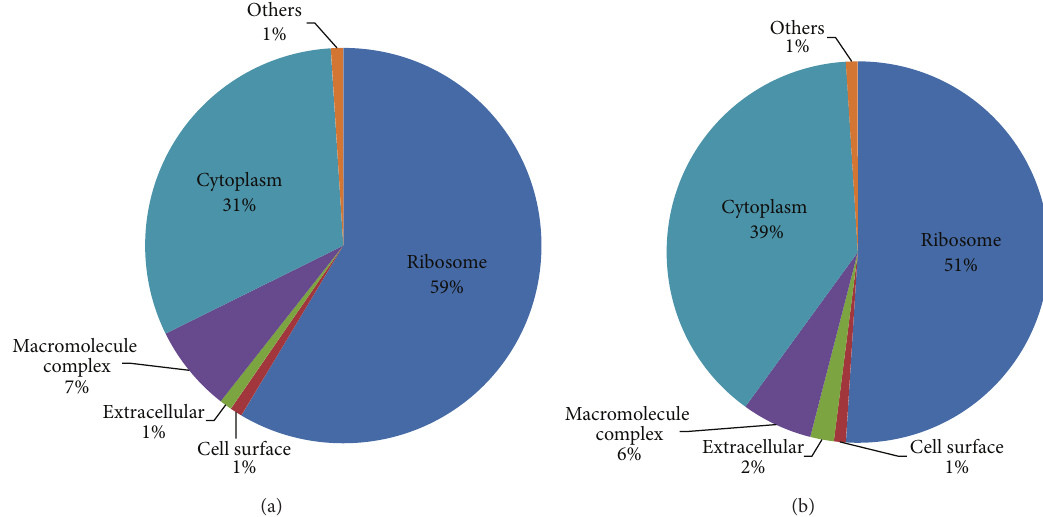
Figure 3: Cellular localization of the growth phase-dependent proteomes of L. lactis strain M4 based on gene ontology using STRAP software. Panel (a), the pie chart shows the cellular localization of L. lactis M4 proteome during the mid-exponential growth phase (OD 600 ∼ 0.8 ); Panel (b), the early stationary growth phase (OD 600 ∼1.8 ) based on gene ontology